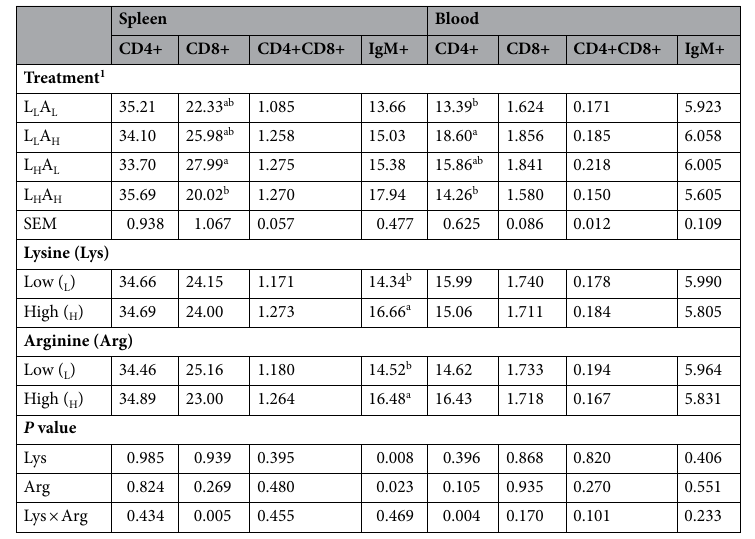
Table 2. Percentages of peripheral blood T cell and B cell subpopulations in turkeys at 9 weeks of age. 1 L L A L diet with low Lys and low Arg levels; L L A H diet with low Lys and high Arg levels; L H A L diet with high Lys and low Arg levels; L H A H diet with high Lys and high Arg levels. a,b Values in same column with no common superscripts denote a significant difference (P ≤